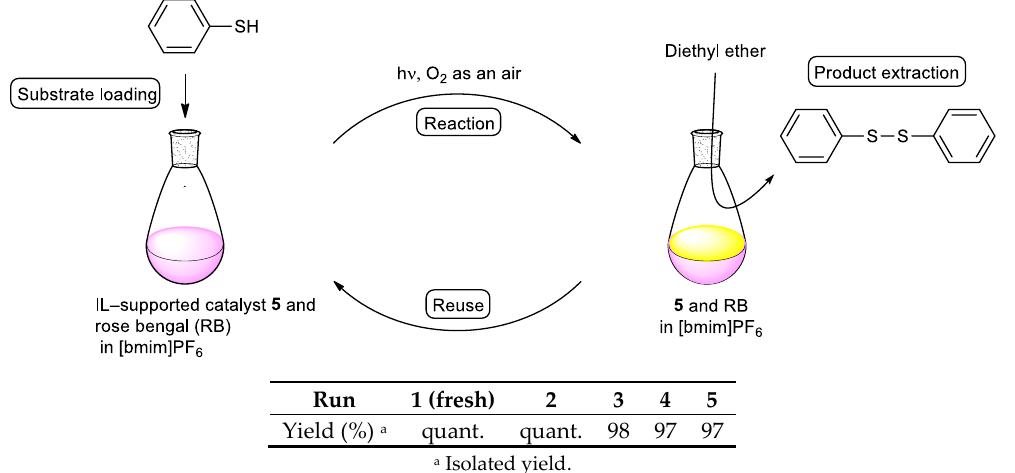
Figure 2. Recycling experiment of IL-supported diphenyl telluride catalyst 5. Condition: thiol (1 mmol), tellurium catalyst (0.2 mmol), rose bengal (0.05 mmol), solvent (10 mL), irradiated with a 500-W halogen lamp under aerobic conditions, 3